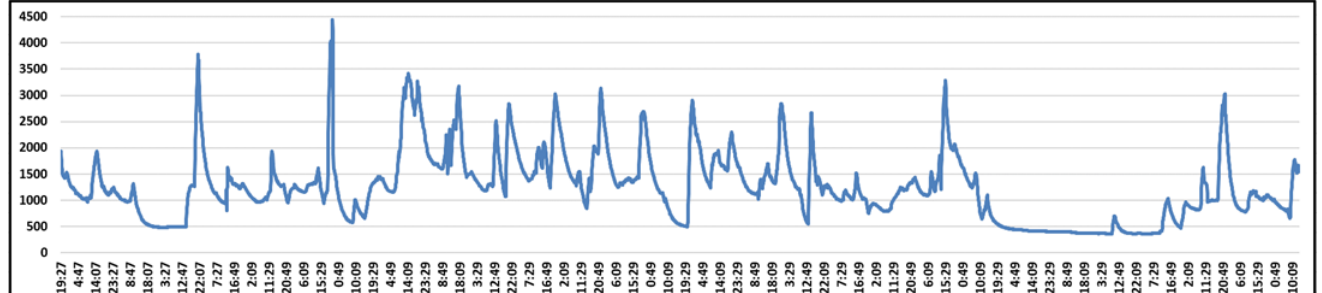
Figure 6. Location of Rotronic measuring devices in the yurt.